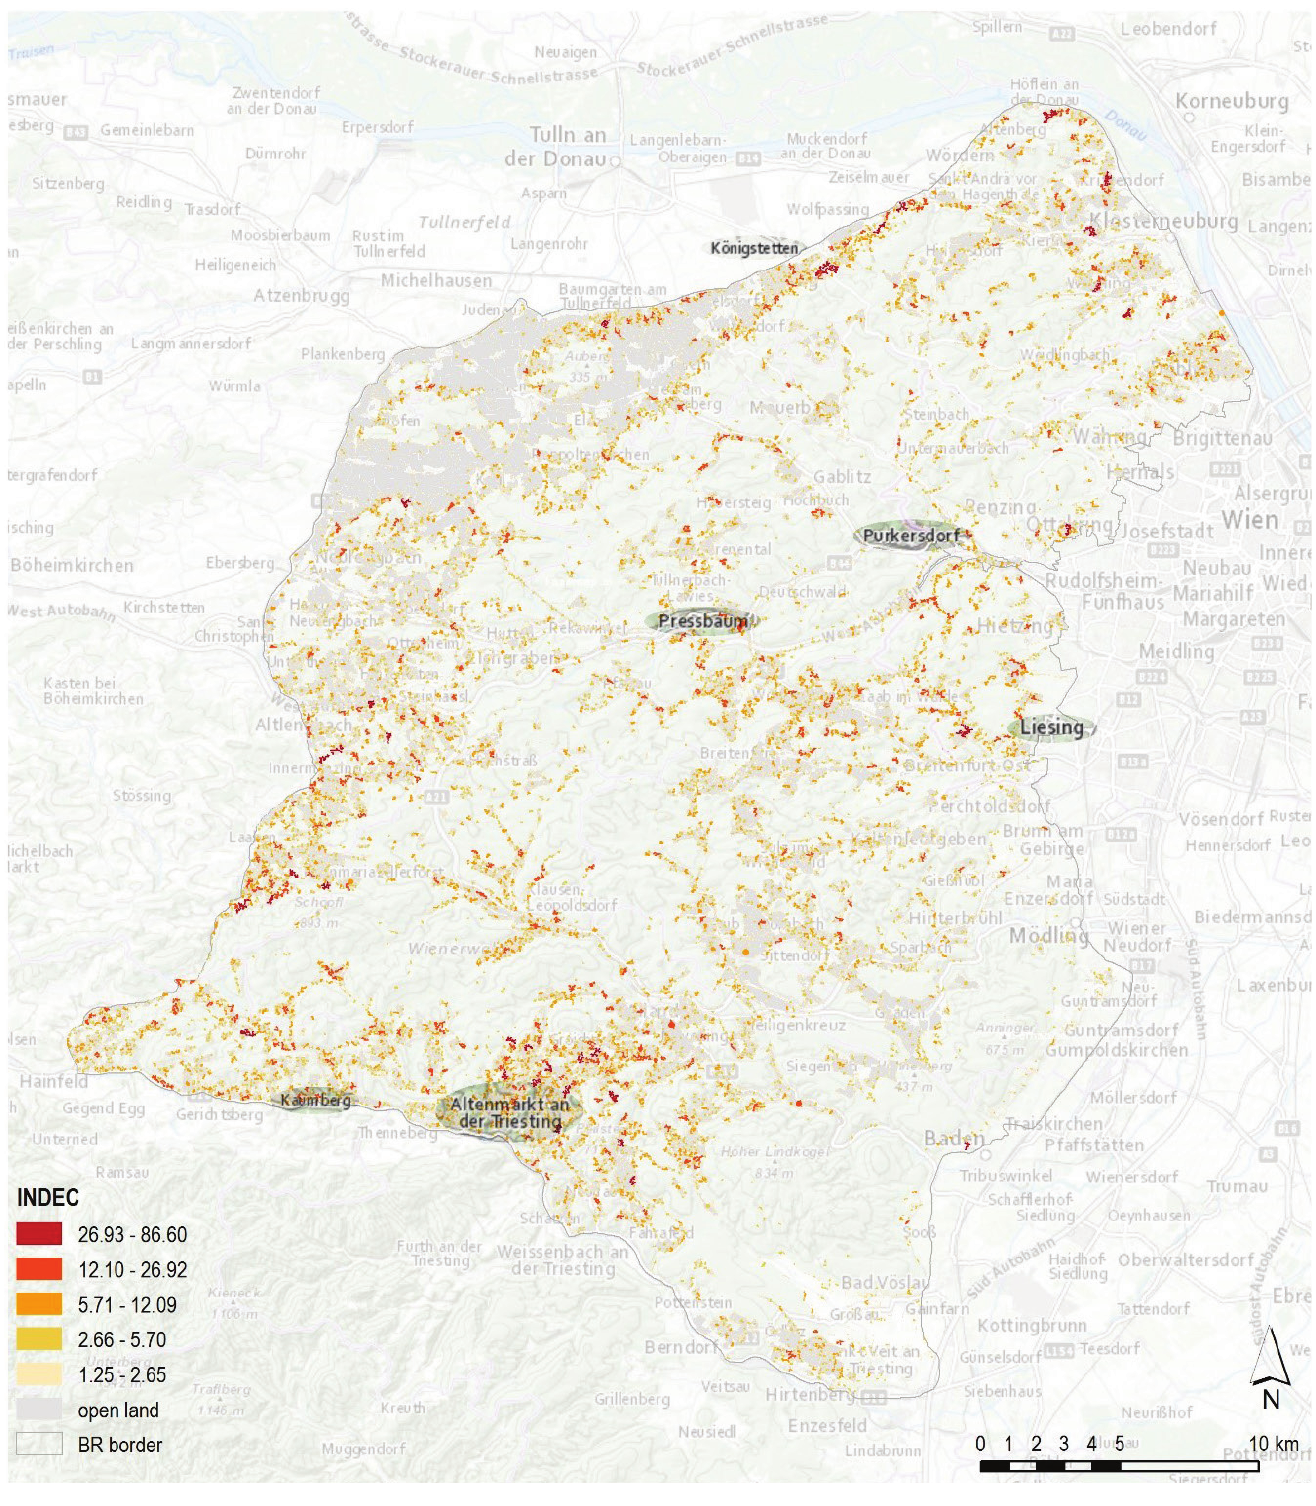
Figure 6: Water supply capacity in the Wienerwald Biosphere Reserve. The colour ramp distinguishes clusters of different INtensity and DEnsity Capacity (INDEC). Data sources: © OpenStreetMap (2018); Staudinger et al. (2014); Wienerwald Tourismus GmbH (2018); www.basemap.at (2018). EPSG: